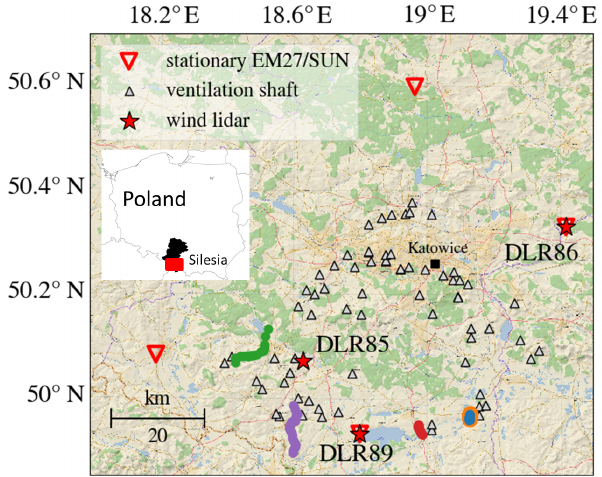
Figure 1. Map of the USCB in southern Poland (see small inset on the left with black illustrating the region of Silesia and red de- picting the map excerpt of the USCB). Ventilation shafts are grey triangles. Coloured dots depict five plume transects measured using the mobile FTS on 24 May at around 07:00–08:00UTC (UTC used for all times throughout the paper, orange), on 24 May around noon (blue), on 1 June (green), on 6 June during morning hours (red), and on 6 June around noon (purple). The most active CH 4 emitters are assumed to be located in the southern part of the USCB, which is why mobile FTS measurements are focused on this area. Station- ary EM27/SUN FTS locations are marked as red triangles; the three wind lidars DLR85, DLR86, and DLR89 are marked as red stars. Eastern and southern wind lidars are placed at the same locations as the respective EM27/SUNs. Background map from ESRI (2019).